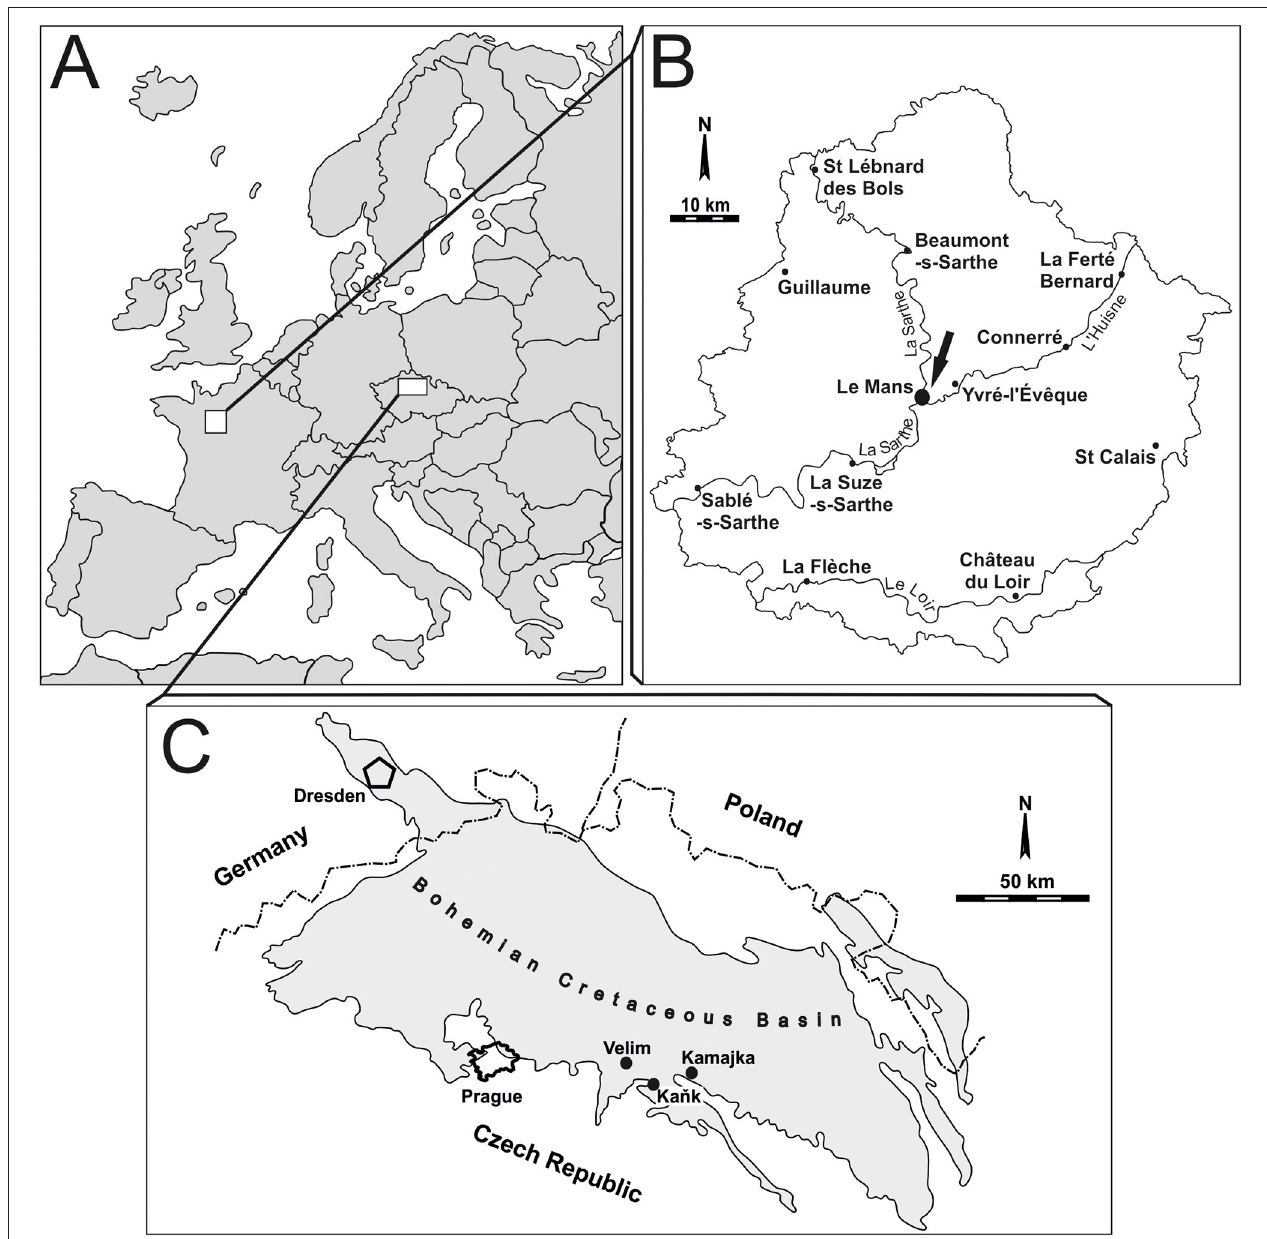
FIGURE 1 | Location map. (A) Simplified map of Europe with the studied areas. (B) Le Mans area (France), the locality is marked by an arrow. (C) A sketch of the Bohemian Cretaceous Basin indicating the location of the studied